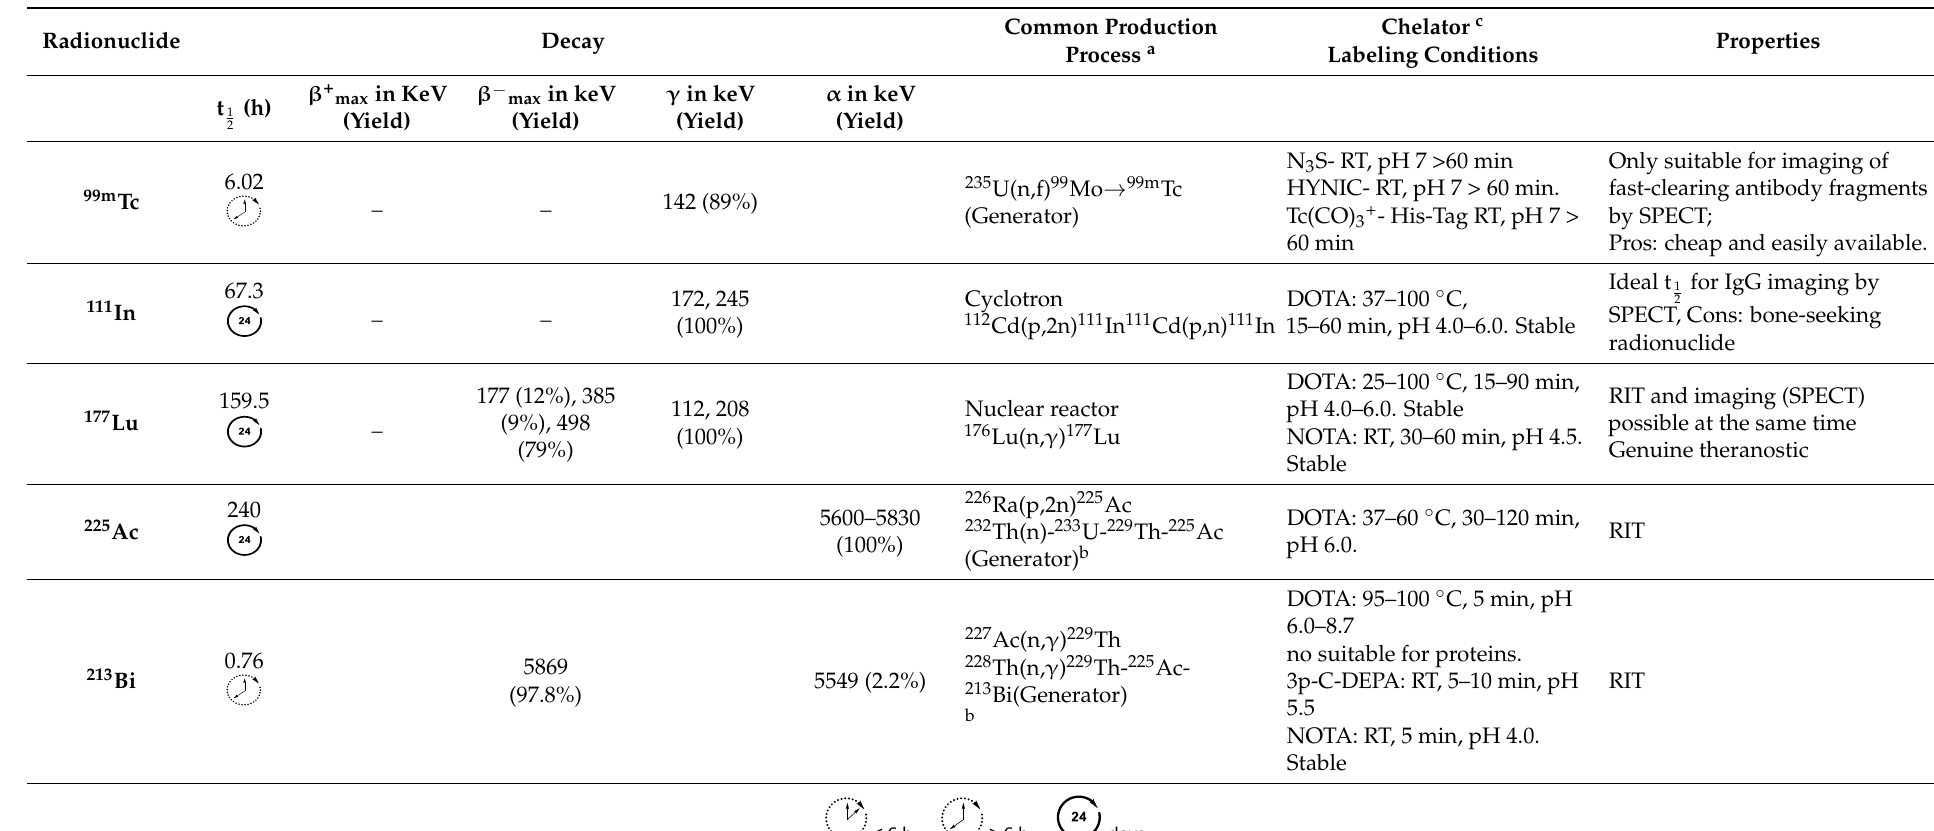
Table 2. Radionuclides used in radioimmunoconjugates for PET, SPECT, and radioimmunotherapy (RIT) . Radionuclide Decay